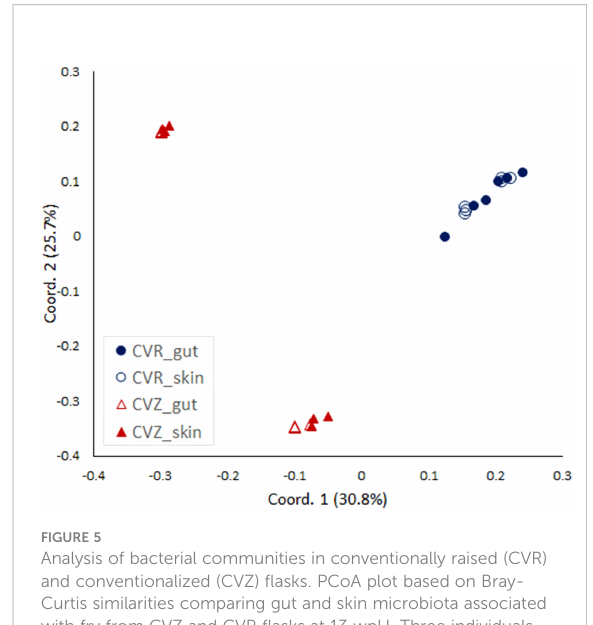
FIGURE 5 Analysis of bacterial communities in conventionally raised (CVR) and conventionalized (CVZ) fl asks. PCoA plot based on Bray- Curtis similarities comparing gut and skin microbiota associated with fry from CVZ and CVR fl asks at 13 wpH. Three individuals from two replicate fl asks were sampled, and their whole gastrointestinal tract (gut) and skin were dissected. The v3+v4 16S rRNA amplicon sequencing was based on total RNA extracts that were DNase treated and reverse transcribed prior to the PCR ampli fi